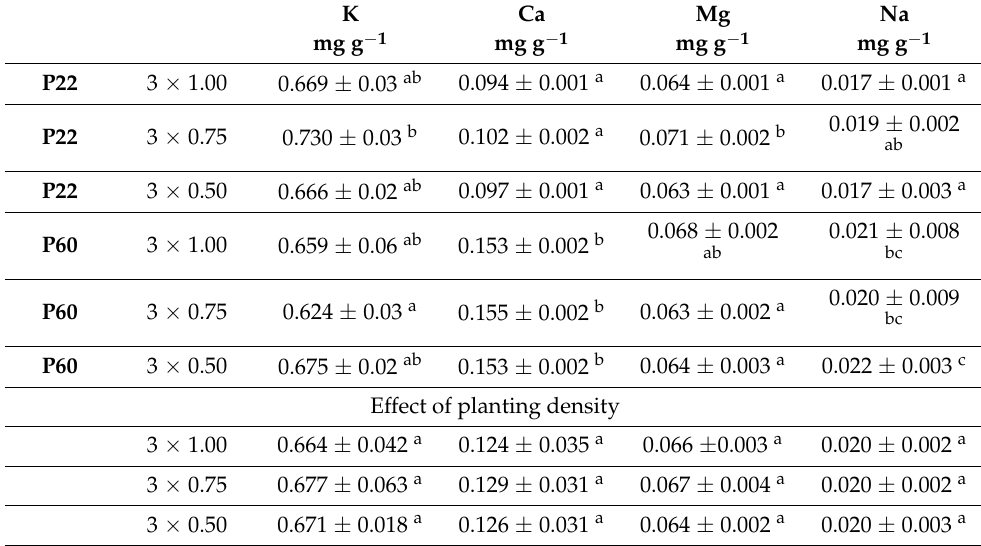
Table 2. The effect of planting distances and rootstock on major elements in cv. Auksis apple fruits. The mean value (n = 3 × 3 = 9) ± standard deviation is presented. The data were processed using a two-way analysis of variance (ANOVA), the Tukey (HSD) test at the confidence level p = 0.05. The different letters in blocks indicate significant differences.